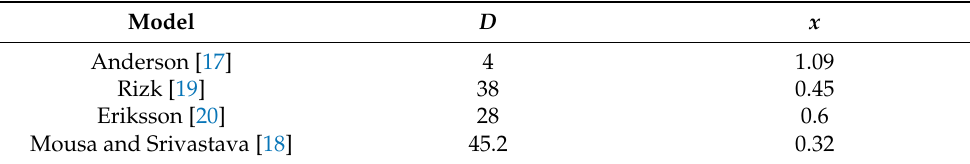
Table 3. D and x parameters from Equation (10) for different models.